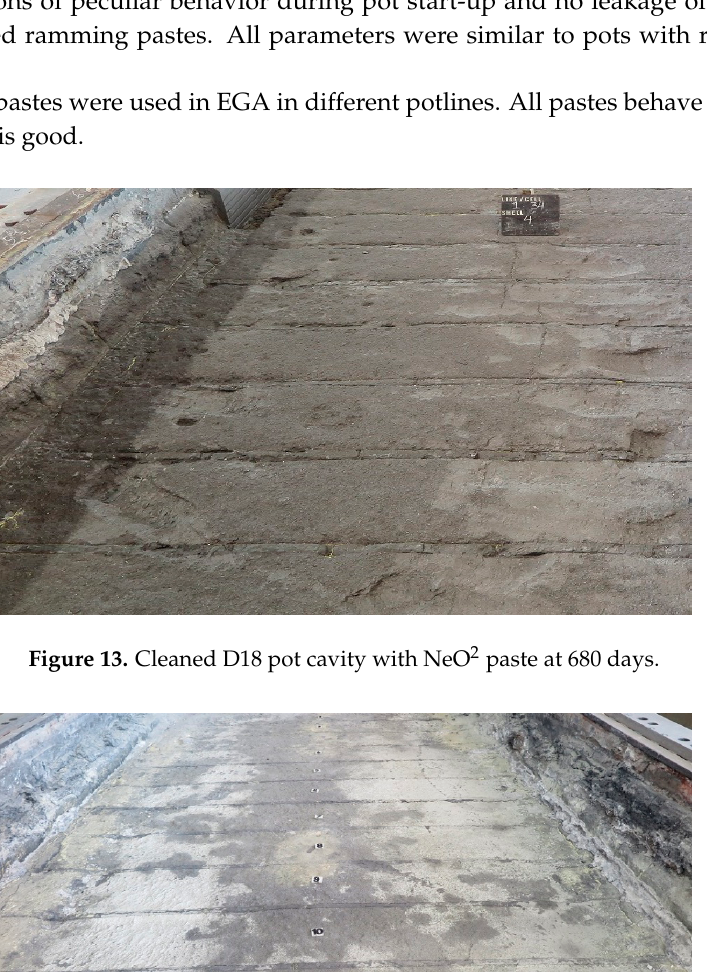
Figure 12. Pot age distribution for DUBAL pots with NeO 2 /CleO 2 pastes, October 2015.